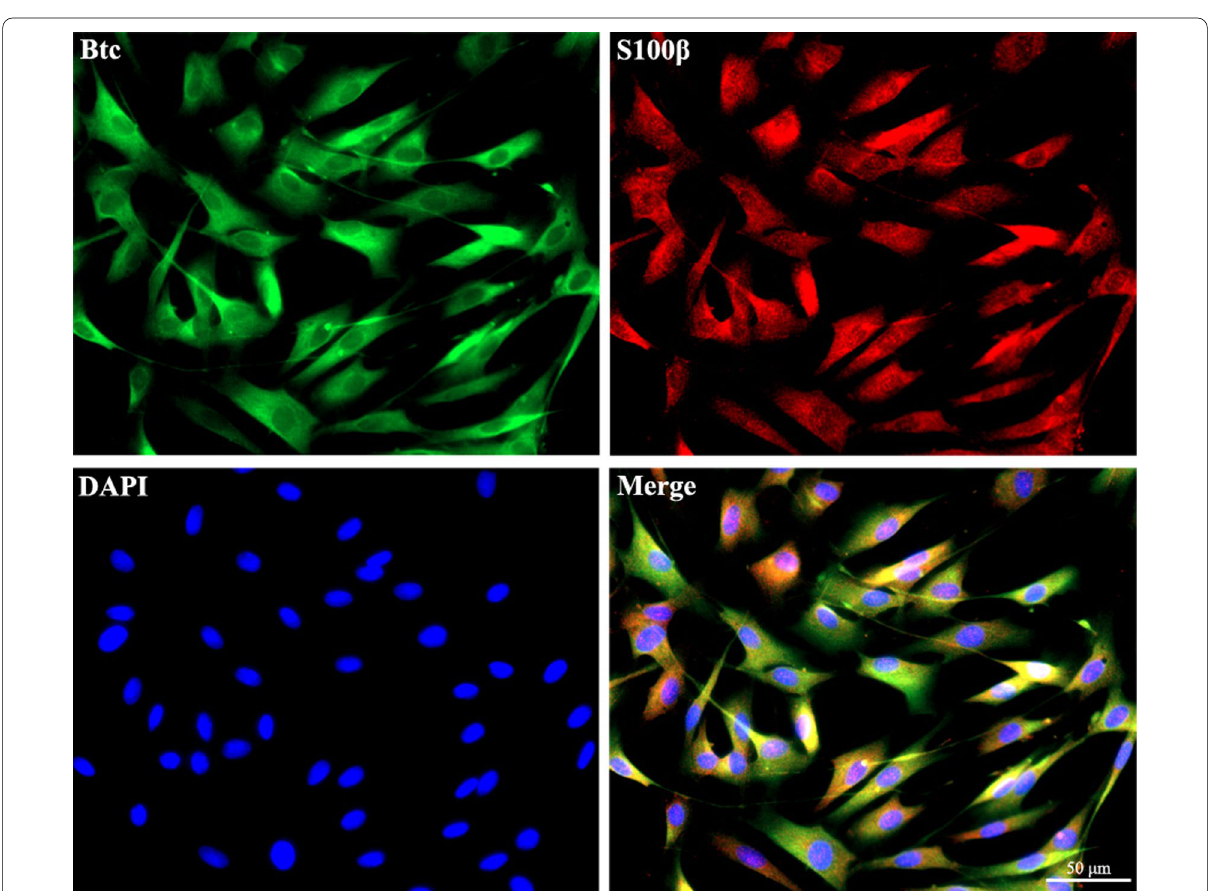
Fig. 1 Immunostaining of Btc in cultured Schwann cells. Red color indicated S100β, green color indicated Btc, and blue color indicated nucleus. Scale bars indicated 50